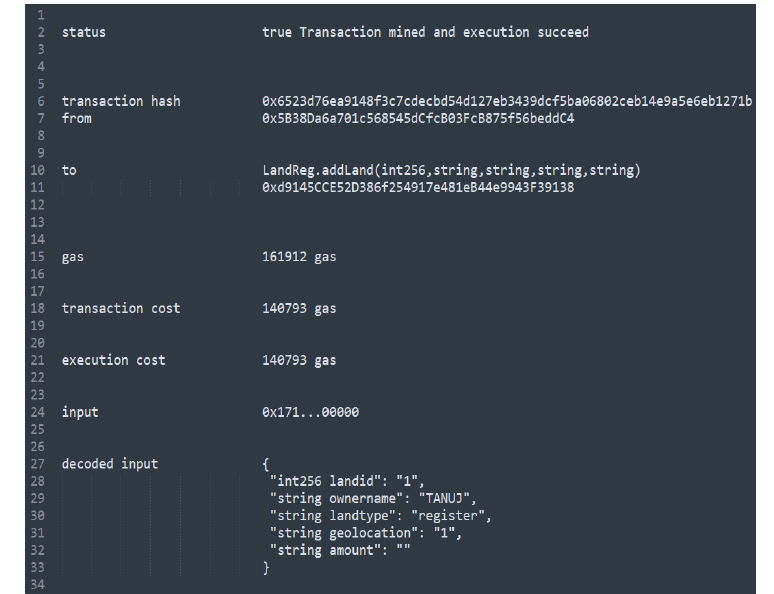
Fig. 2. Blockchain